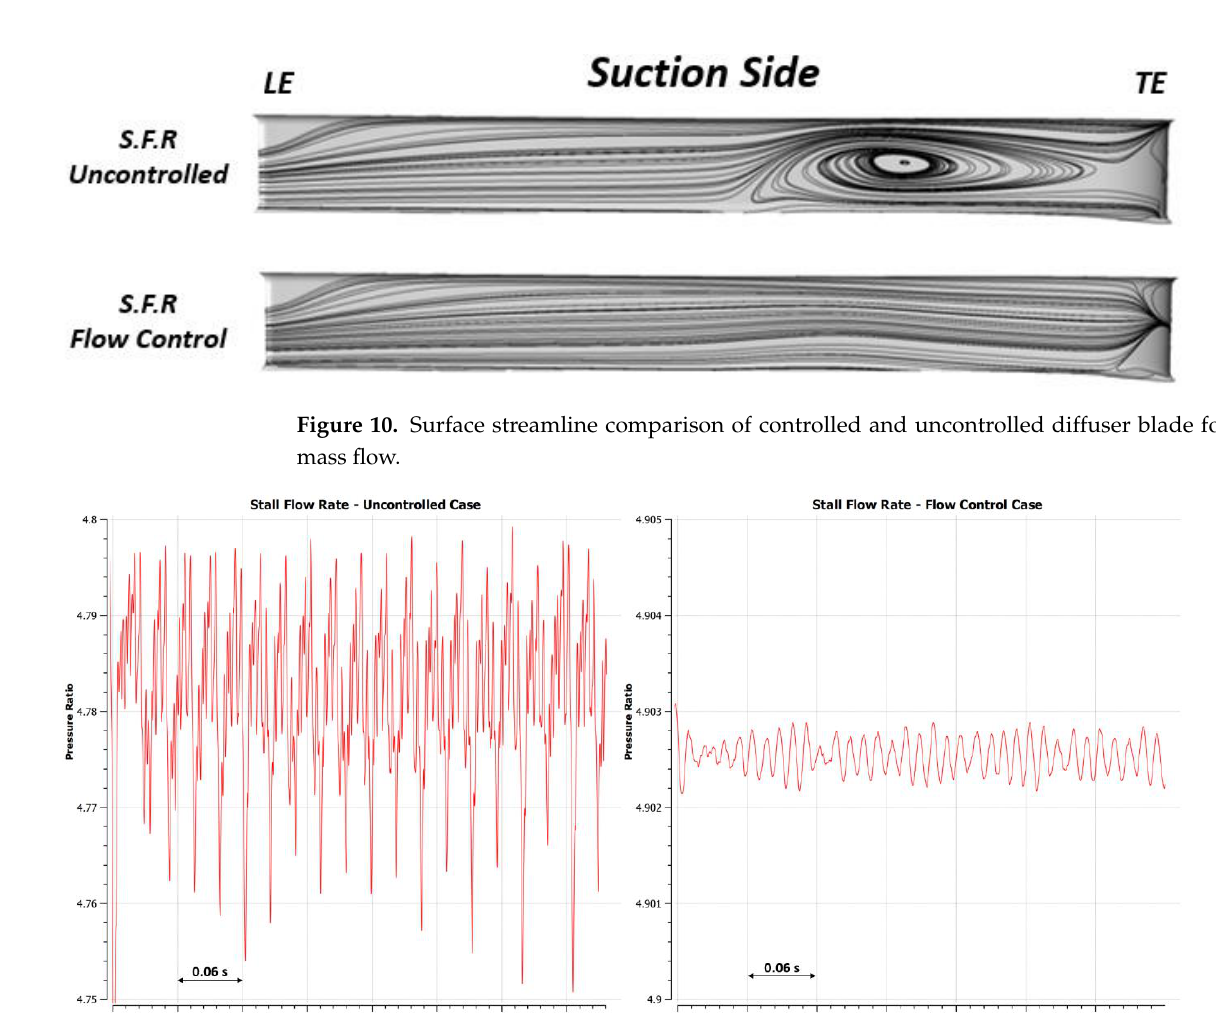
Figure 9. Results for controlled and uncontrolled cases near stall flow rate: ( a ) pressure ratio, π; ( b ) adiabatic efficiency, η.